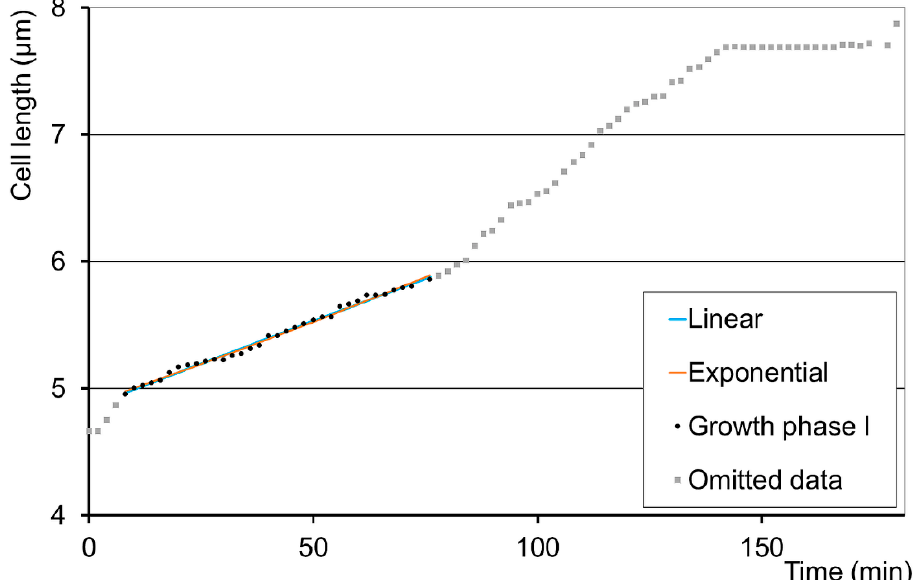
Figure 2. Illustrative length growth profile of the same individual wee1-50 mutant fission yeast cell, which is given in Figure 1. Growth phase I is emphasized here, as the rest of the data is omitted from this analysis. The two fitted models (linear, exponential) are shown.